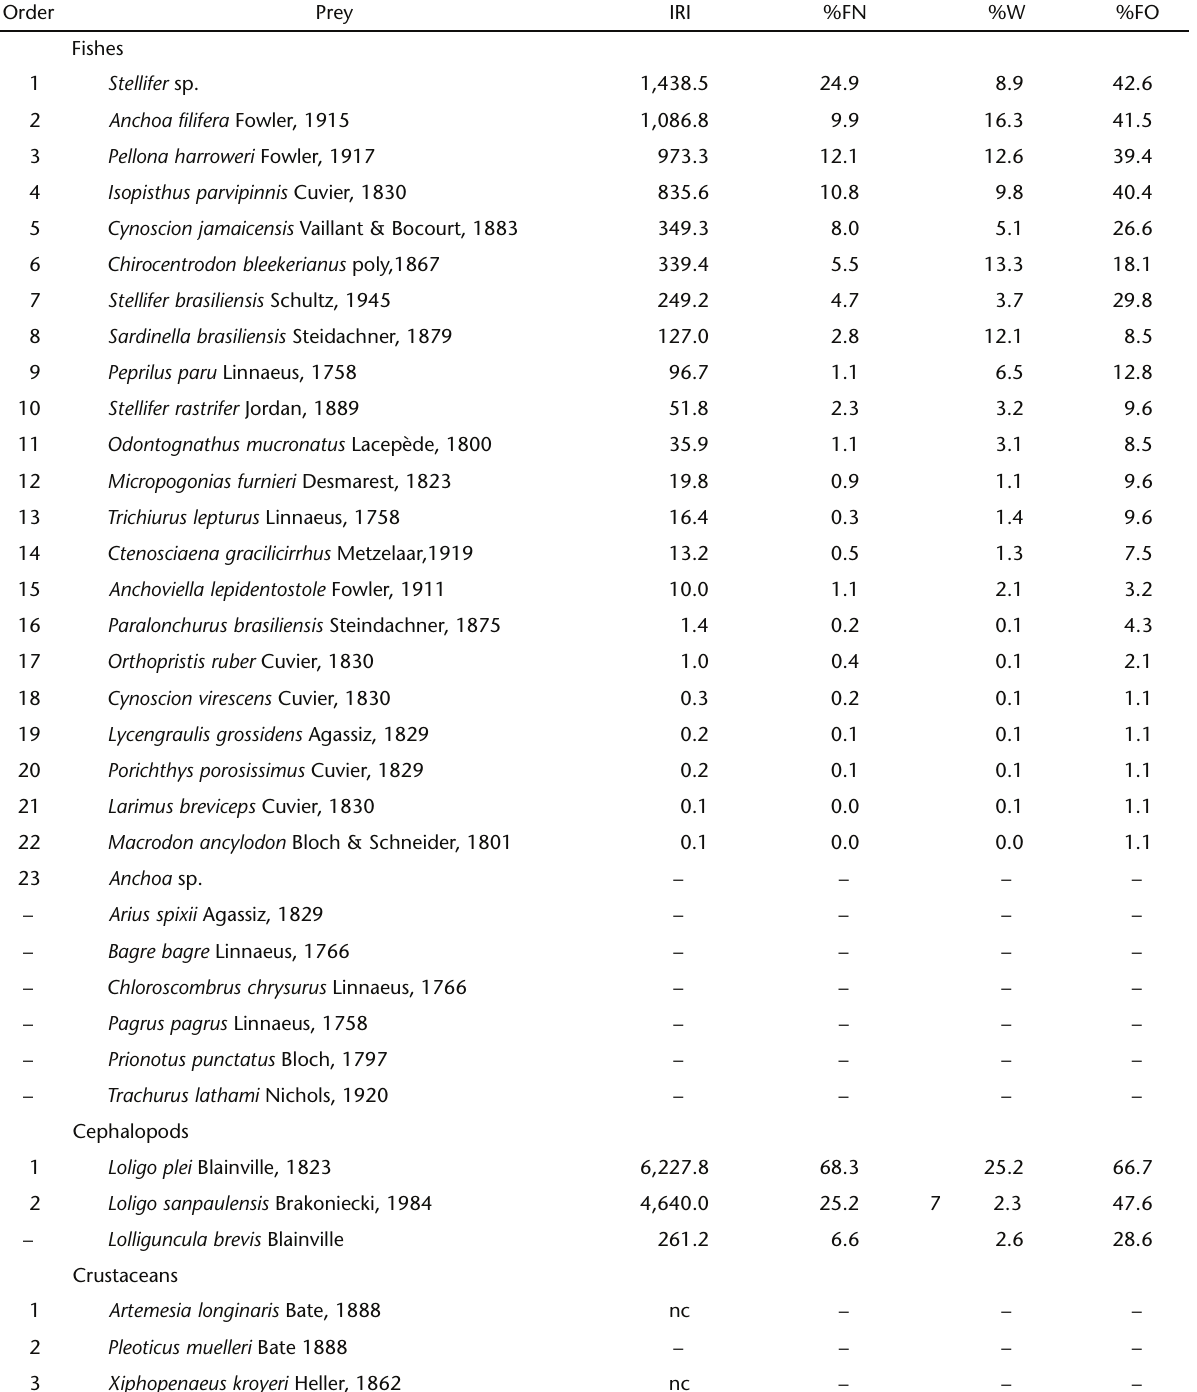
Table II. Prey species consumed by P. blainvillei in northern Rio de Janeiro, with the Index of Relative Importance (IRI), numeric frequency (%FN), biomass (%W) and occurrence (%FO). Order Prey IRI